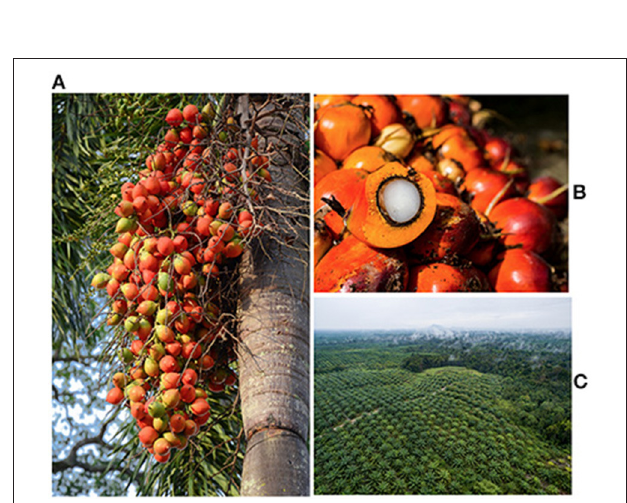
FIGURE 6 | Oil Palm (Elaeis guineesnsis). (A) Oil palm fruits. Source: T. Crazzolara. CC BY 2.0. (B) Whitish center of an oil palm kernel. Source: